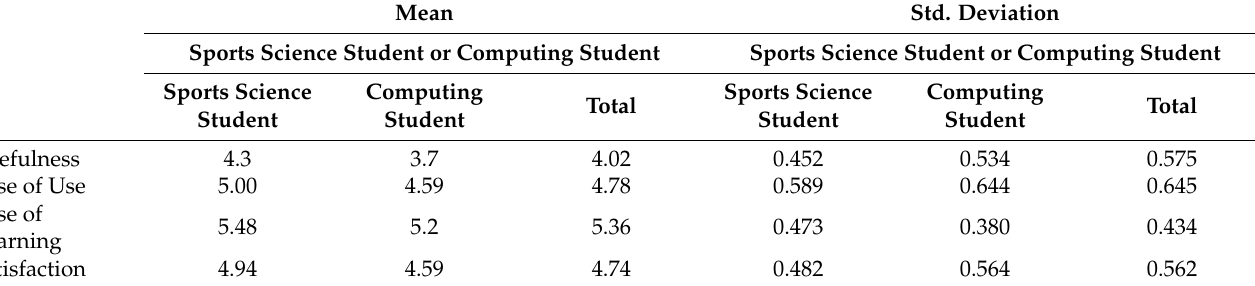
Table 1. USE questionnaire results.